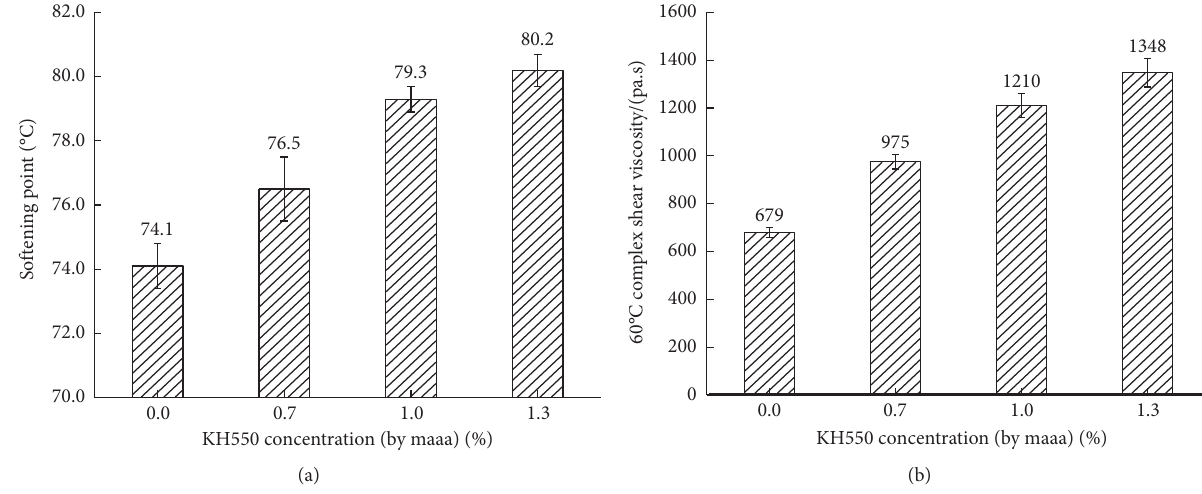
Figure 3: Effect of KH550 concentration on the asphalt rubber’s high-temperature performance: (a) softening point; (b) 60 ° C complex shear viscosity. Table 4: Test results of the low-temperature performance of the asphalt rubber. Modified asphalt